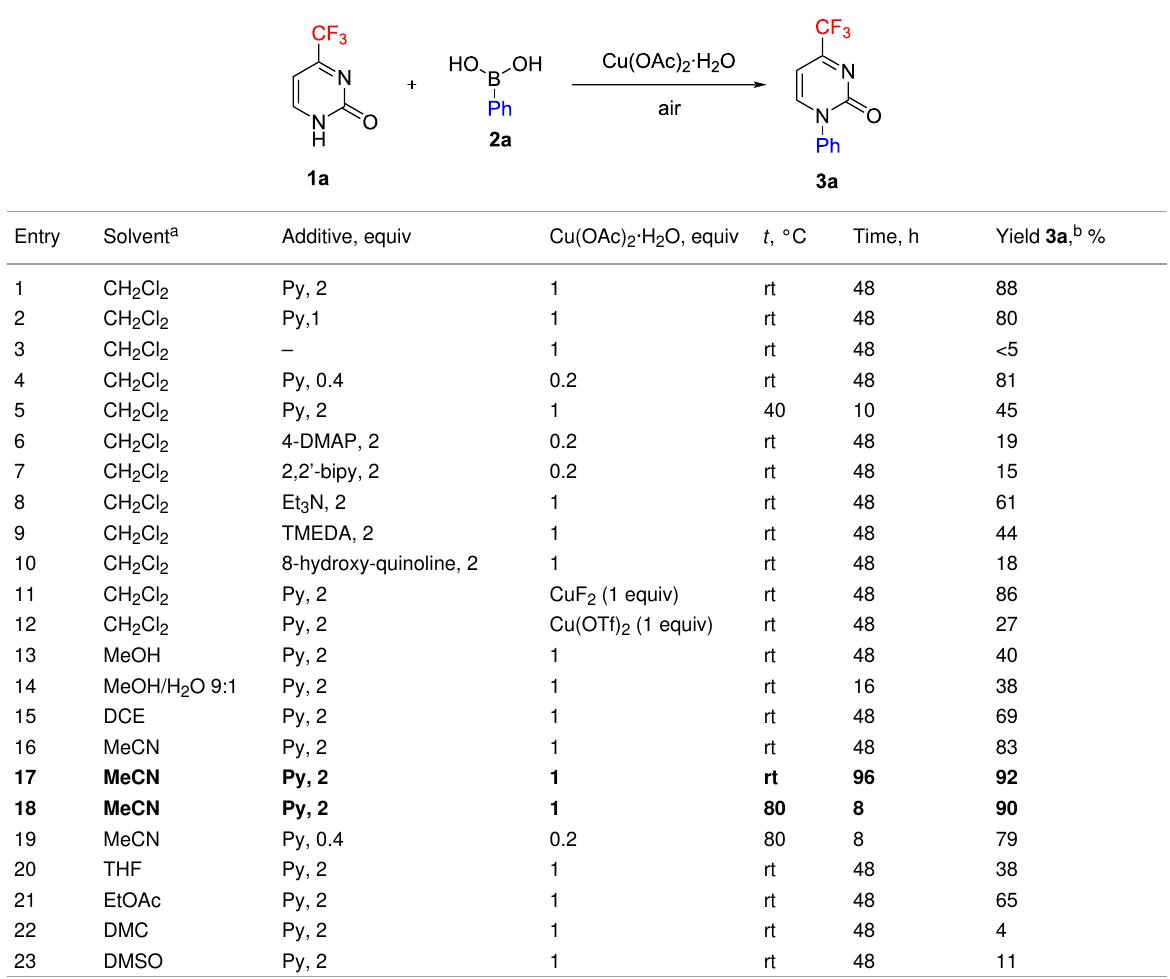
Table 1: Effect of the solvent, base, and temperature on the CEL reaction of 4-trifluoromethylpyrimidin-2(1 H )-one ( 1 а ) with phenylboronic acid ( 2a